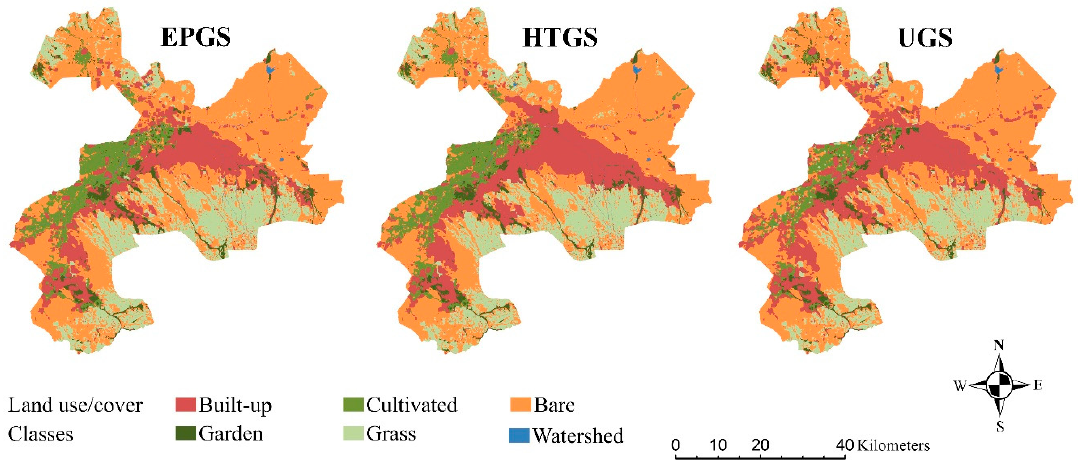
Figure 10. Results of predicting LUCC in growth scenarios from 2020 to 2050.